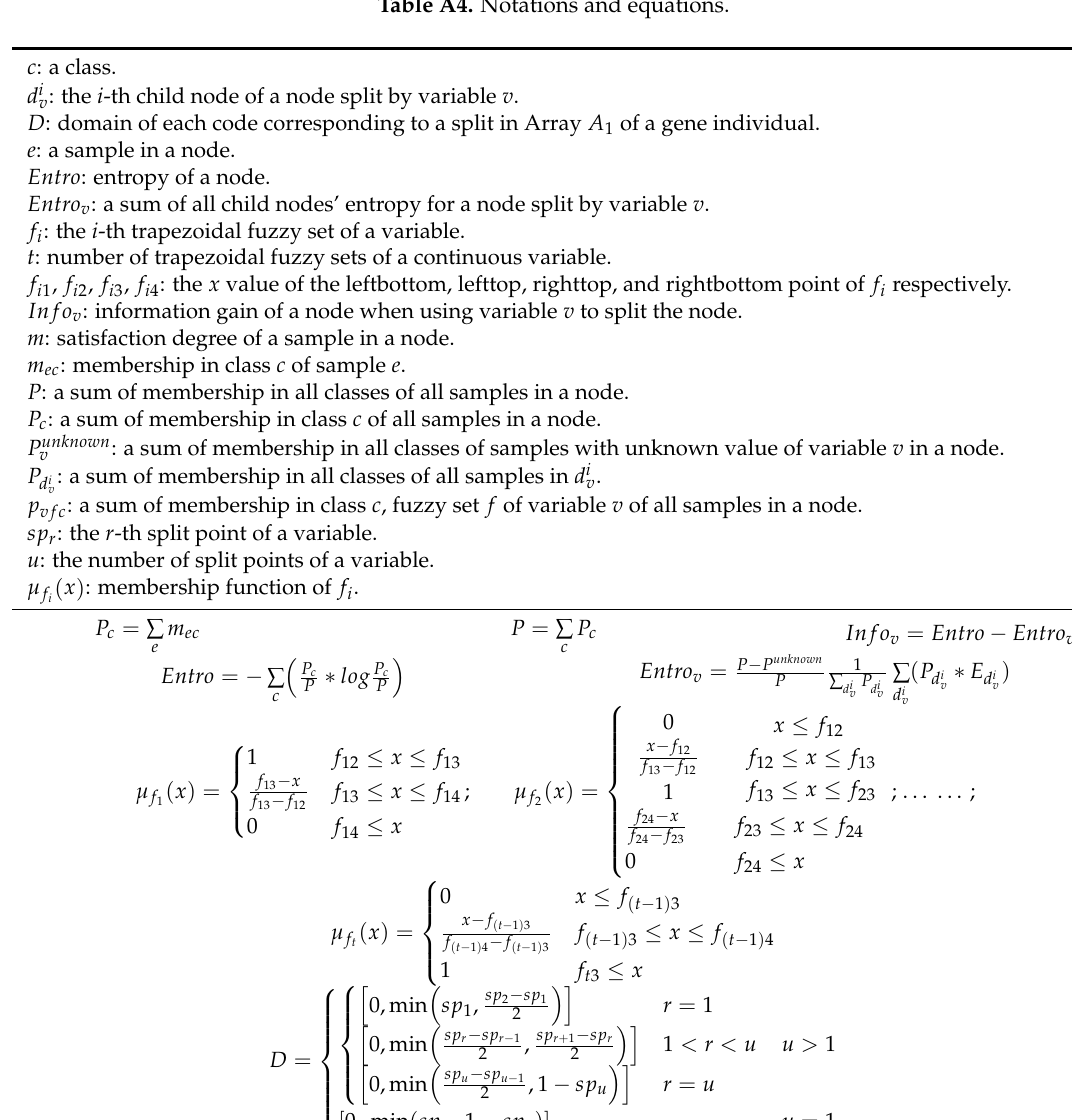
Table A4. Notations and equations.